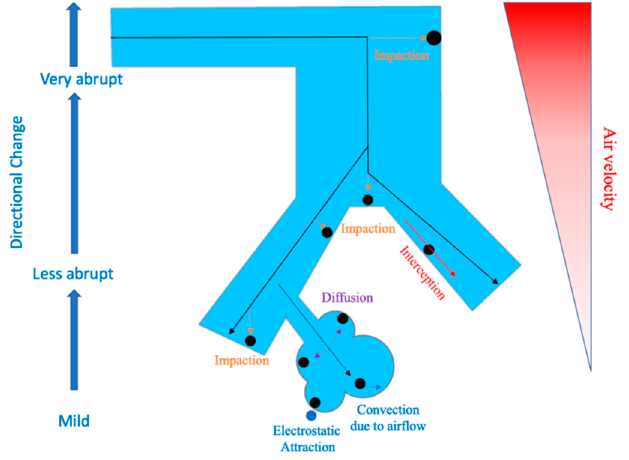
Figure 2. Deposition mechanisms in the respiratory tract (RT) [4].